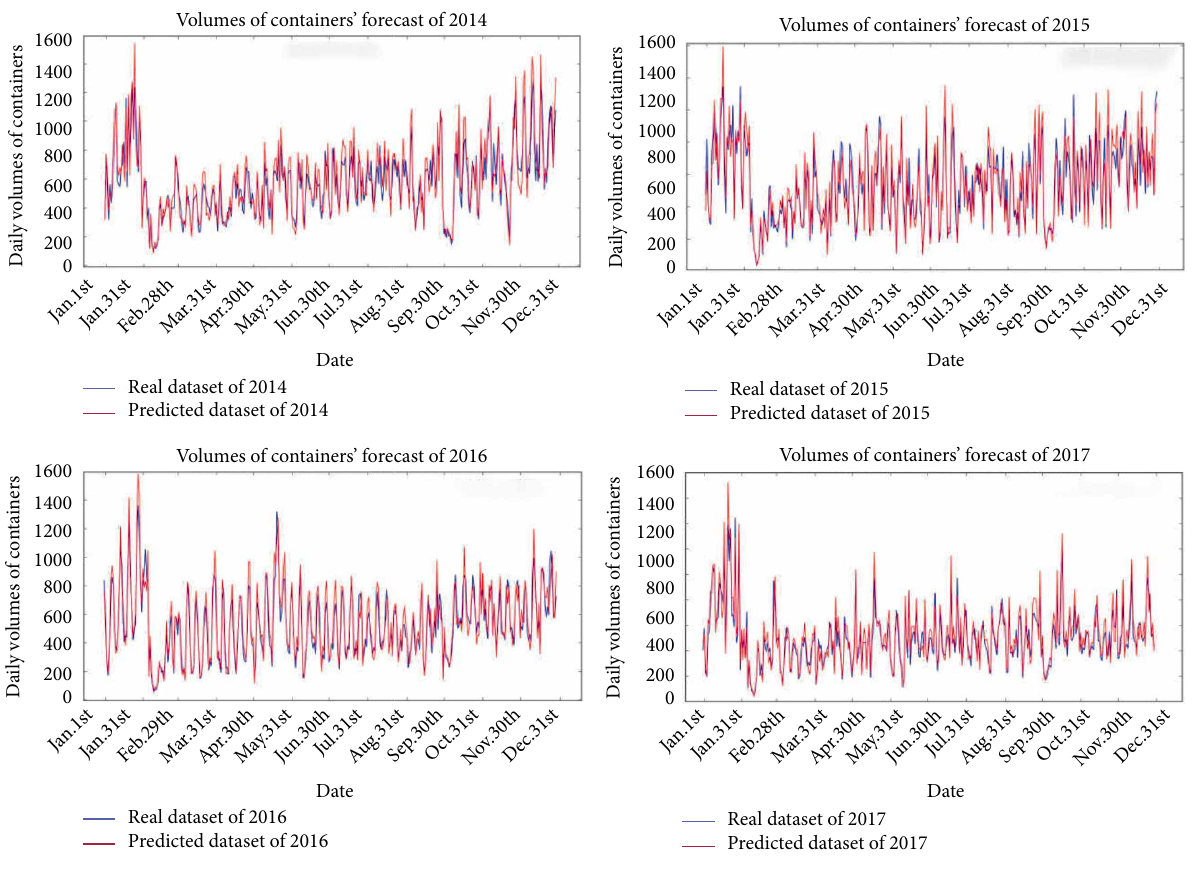
Figure 9: The prediction results with BP neural